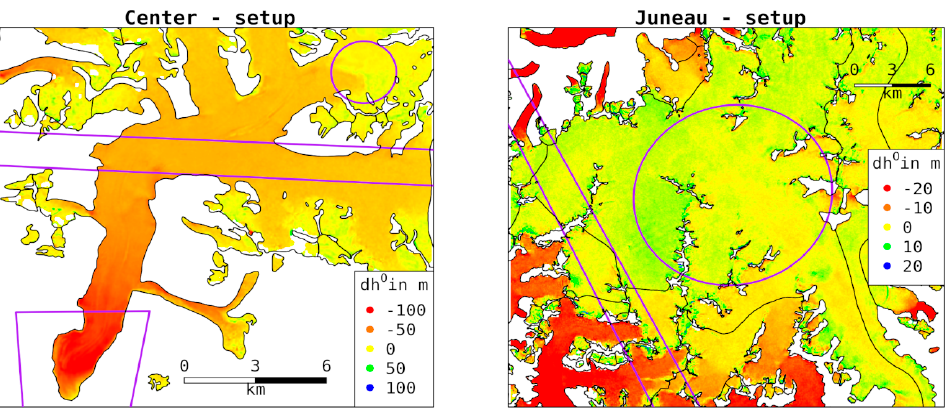
Figure 2. Original elevation change fields of subsets of the study region (Figure 1) used for analysis of the void filling approaches on large data voids (purple polygons). Results of the different void filling approaches are provided in Figure 4, Figures S1 and S2.